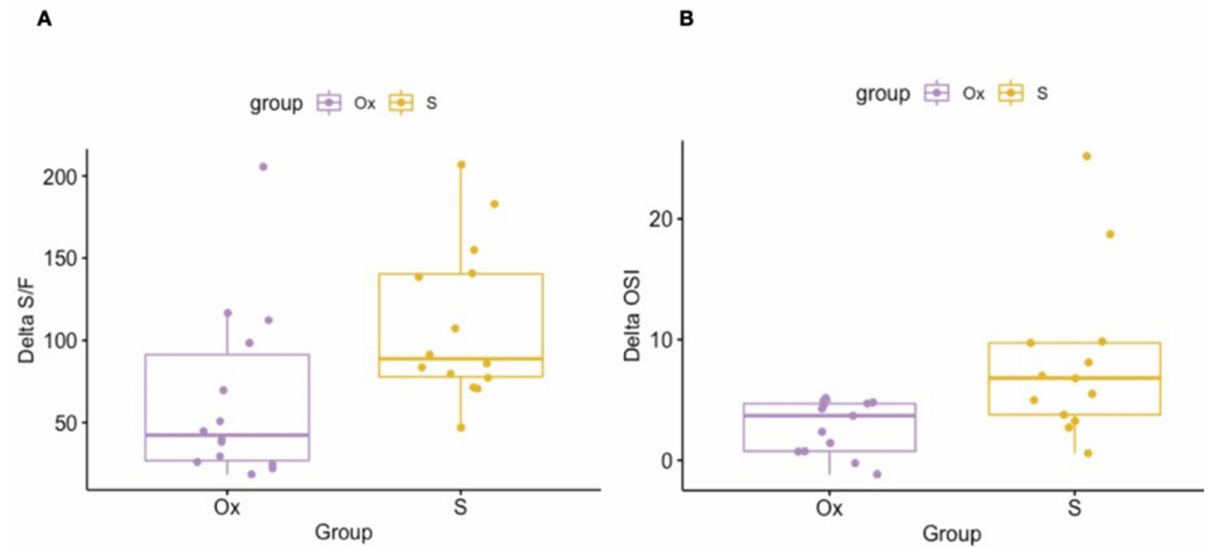
Figure 3. ( A ) difference between initial and final oxygen saturation/fraction of inspired oxygen ratio (Delta S/F) in the LUSTR-group and Ox-group. ( B ) difference between initial and final oxygen saturation index (Delta OSI) of the LUSTR-group and